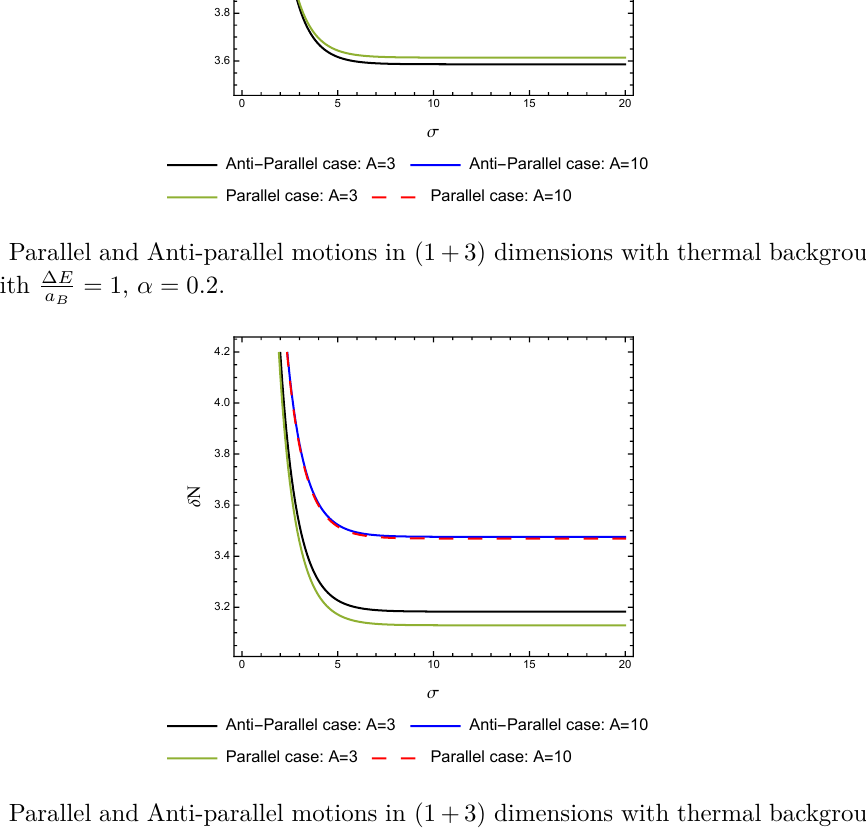
Figure 27 . Parallel and Anti-parallel motions in (1 + 3) dimensions with thermal background: δ N Vs σ plot with ∆ E = 1 , α = 0 . 707 a B